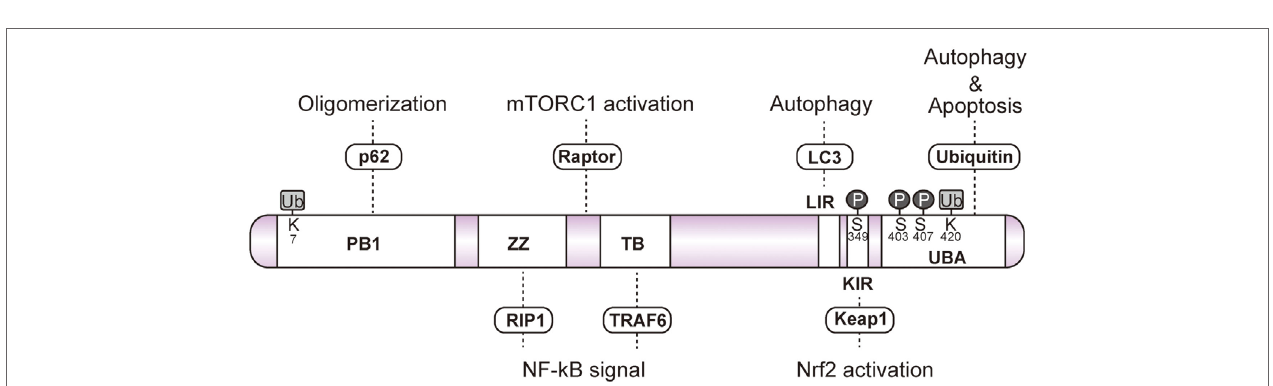
FigURe 2 | Schematic domain of p62. p62 forms a self-oligomer through its Phox and Bem1 (PB1) domain. The zinc finger (ZZ) and TRAF6-binding domains (TB) interact with RIP1 and TRAF6, respectively, to regulate NF- κ B signaling. Raptor interacts with the unidentified region between ZZ and TB to activate mechanistic target of rapamycin complex 1. Light chain 3-interacting region and the C-terminal ubiquitin-associated domain (UBA) are essential for the sequestration of ubiquitinated substrates into the autophagosome. Phosphorylation of serine 403 and serine 407 residues in the UBA domain facilitates the interaction with ubiquitin. Phosphorylation of Keap1-interacting region at serine 349 enhances the interaction with Keap1. The UBA domain interacts with ubiquitinated caspase8 to induce apoptosis. Ubiquitination of the PB1 domain at lysine 7 abrogates p62 oligomerization. Ubiquitination of the UBA domain at lysine 420 disrupts the interaction with the ubiquitin chain.